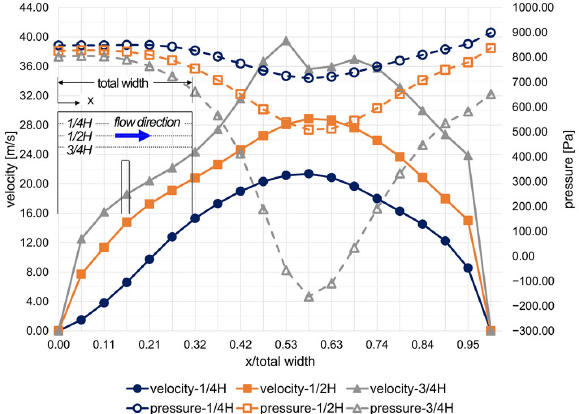
Figure 10. Flow characteristics of the turning region (Re = 24,230).